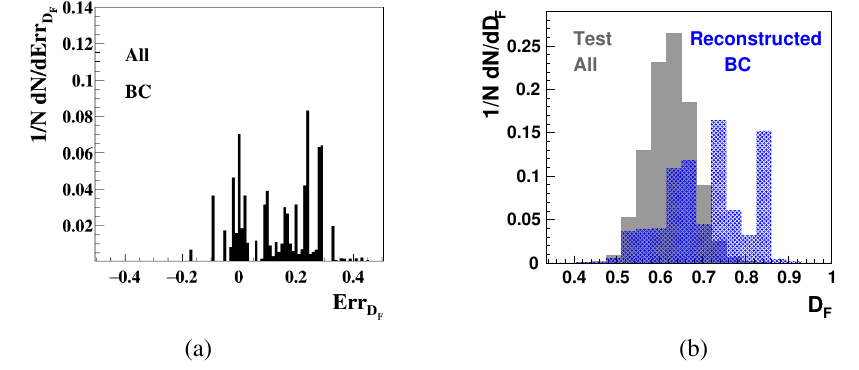
Figure 6. The event distributions by errors Err D BC -method for the full data set (the gray and blue areas correspond to the test and reconstruction distributions,